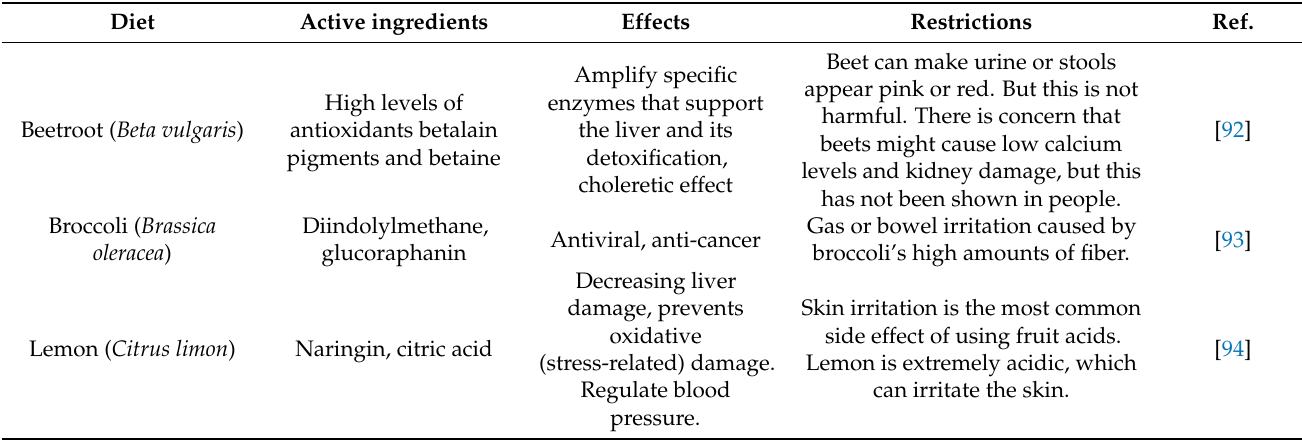
Table 6. Foods for cleansing and